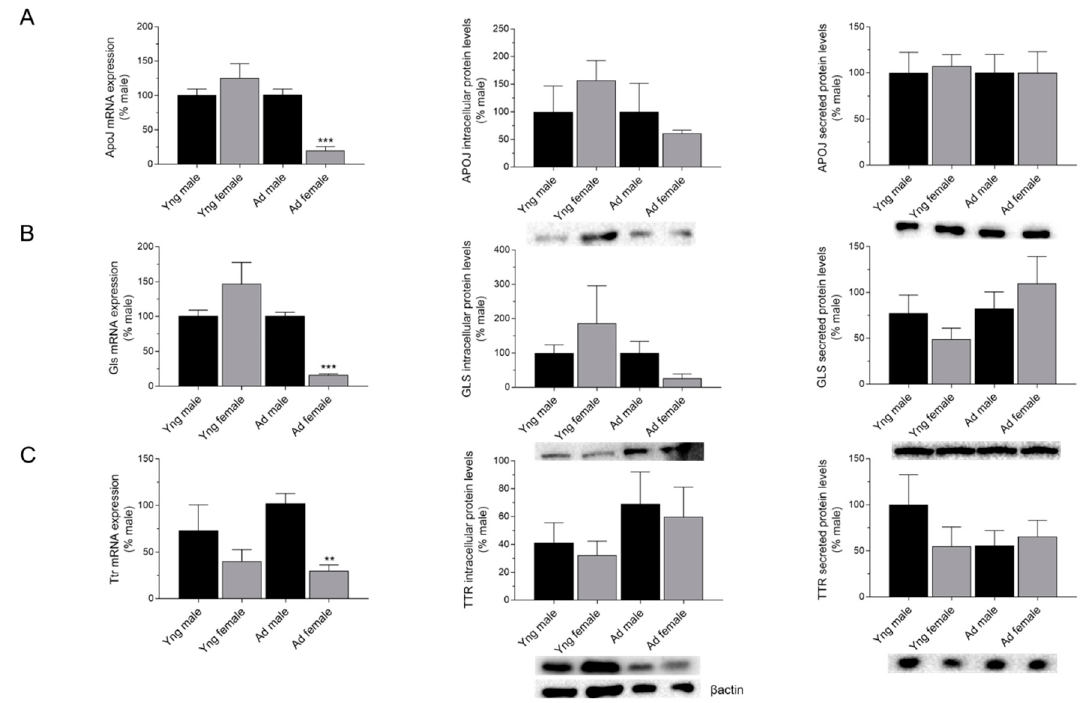
Figure 2. Effects of sex on the expression of apolipoprotein J (APOJ), gelsolin (GLS), and transthyretin (TTR) in the choroid plexus (CP). mRNA expression, intracellular protein, and secreted protein levels of APOJ ( A ), GLS ( B ), and TTR ( C ) in CP explants and conditioned media of male and female from young (Yng) and adult (Ad) groups was analyzed by real time RT-PCR and Western blot, respectively. Bar graphs represent mean ± SEM (N ≥ 3; ** p < 0.01, *** p < 0.001; One-way ANOVA followed by Bonferroni’s post hoc test).